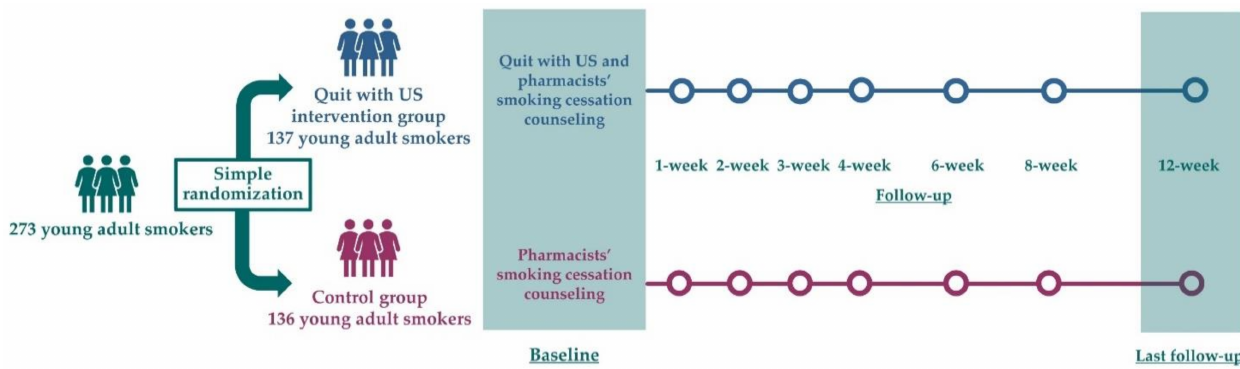
Figure 1. Study protocol of Quit with US